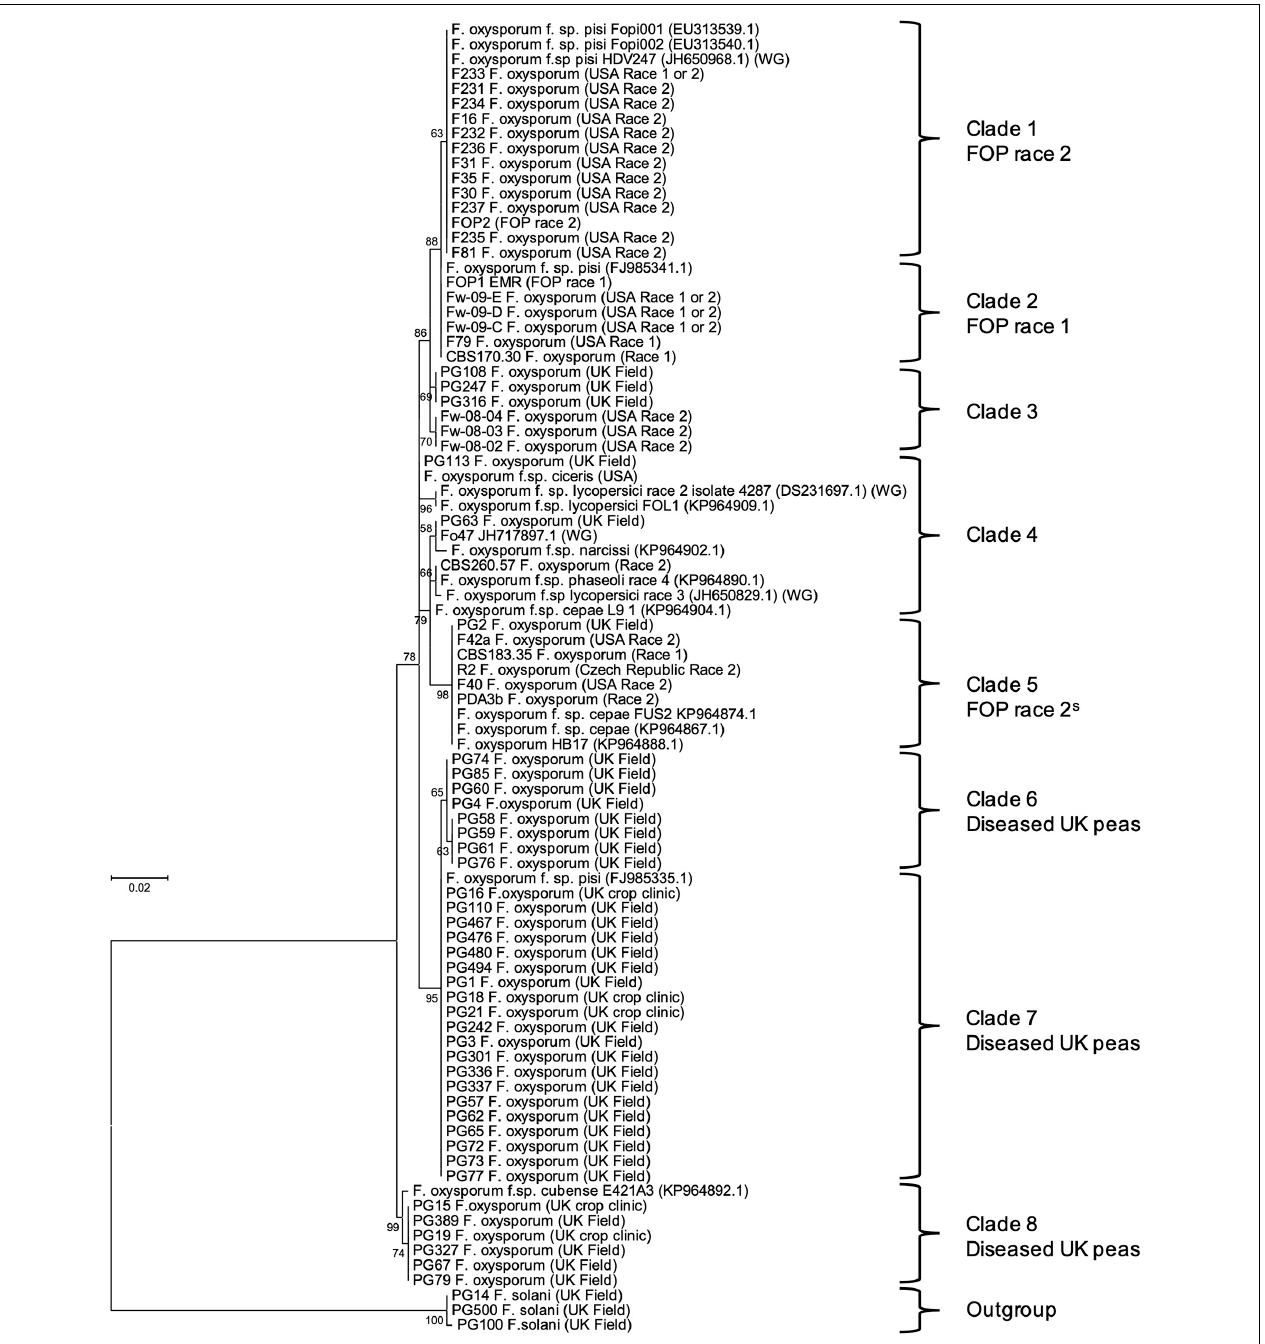
FIGURE 1 | Maximum likelihood tree for 40 Fusarium oxysporum isolates from diseased United Kingdom peas (coded PG), 28 F. oxysporum f. sp. pisi (FOP) isolates from other researchers (with original race designation) and other F. oxysporum formae speciales , based on an alignment of translation elongation factor 1 α ( TEF ) sequences. Numbers represent bootstrap percentage values from 1,000 replicates. Scale bar indicates 0.02 substitutions per site. The tree is rooted through three F. solani isolates